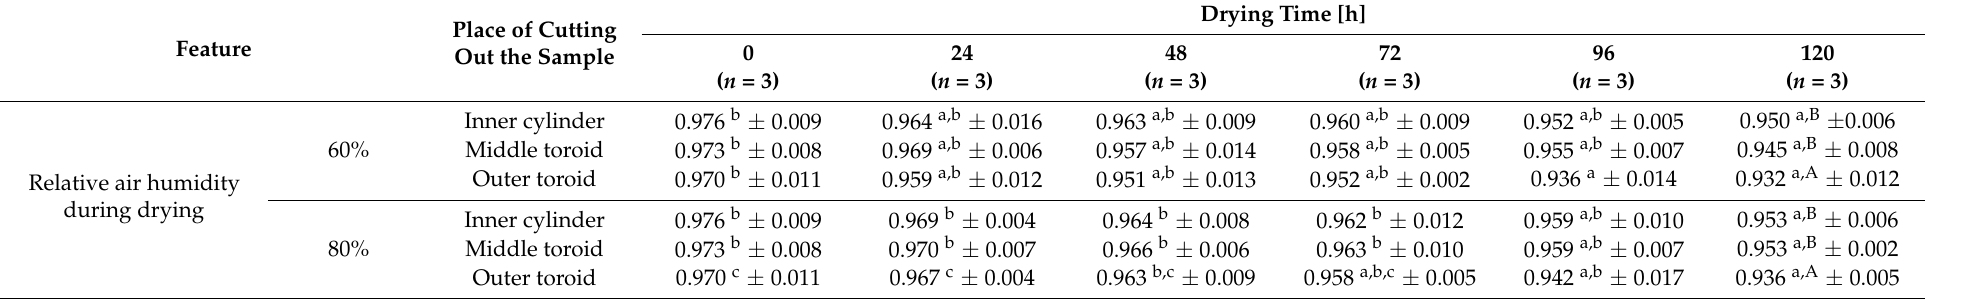
Table 3. Changes in the water activity of KSS sausages during the drying process (mean ± standard deviation).